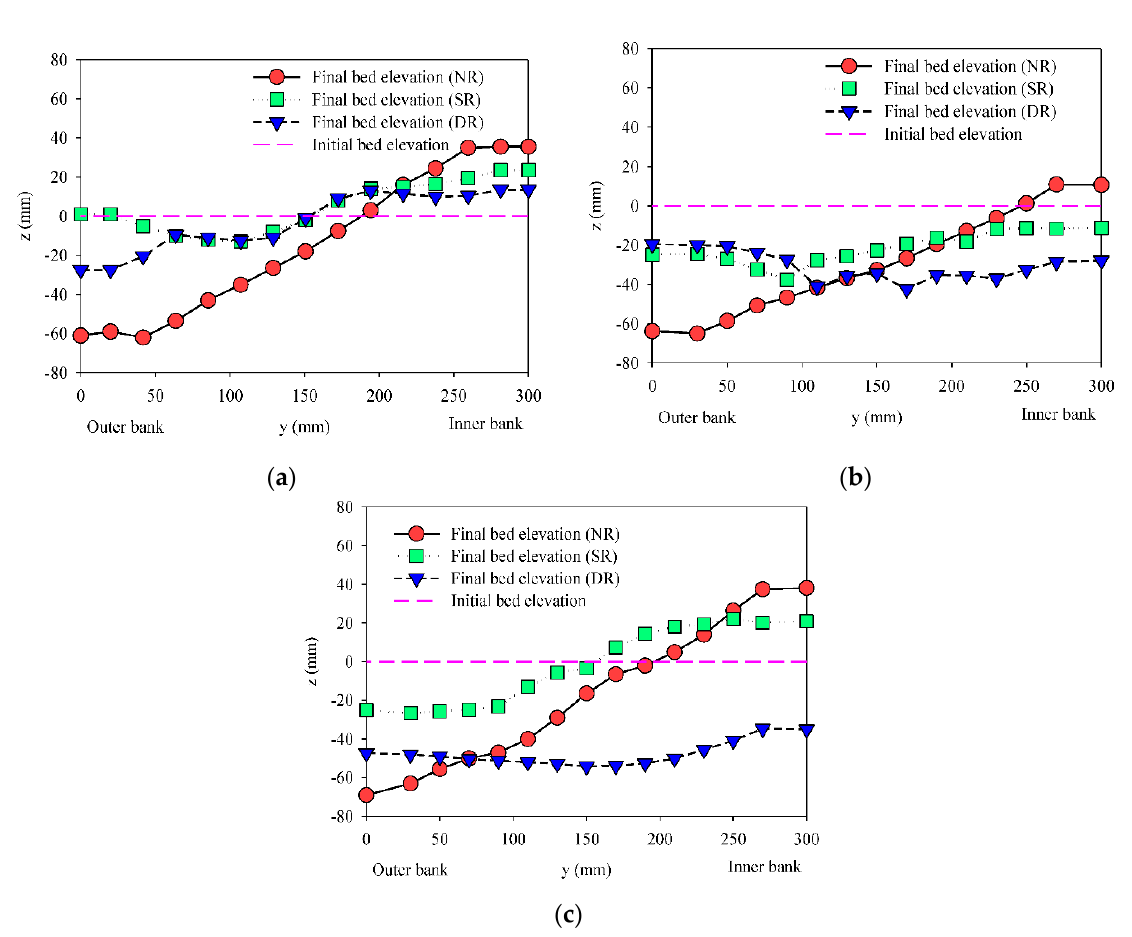
Figure 6. Bed elevation at cross-section C5: ( a ) Q = 10, ( b ) Q = 15 and ( c ) Q = 20 L/s.